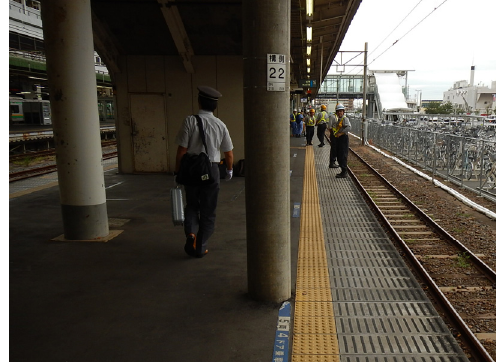
Figure 20. Obstacle pole to measurement